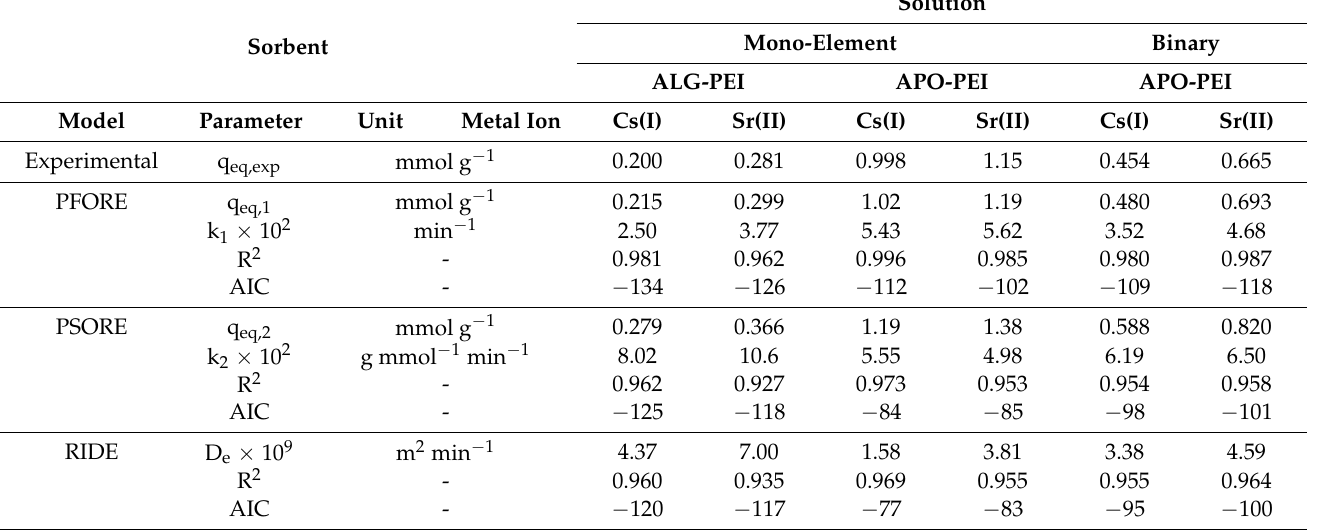
Table 1. Uptake kinetics for the sorption of Cs(I) and Sr(II) using ALG-PEI and APO-PEI sorbents: Parameters of the